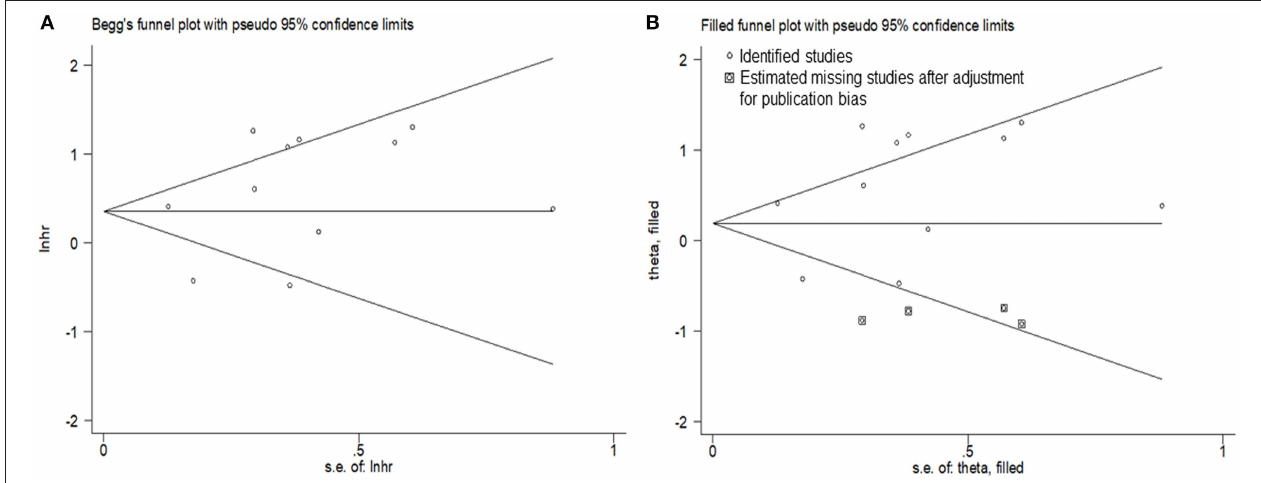
FIGURE 7 | Begg’s test (A) and trim and fill method funnel plot (B) for overall survival.